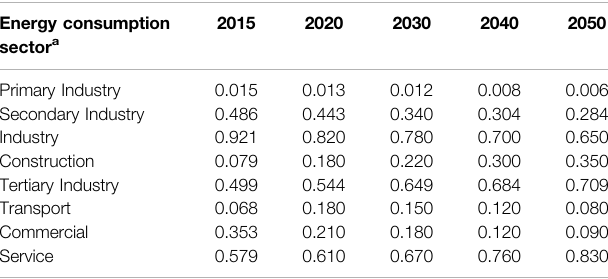
TABLE 3 | References for the future development trend of industry